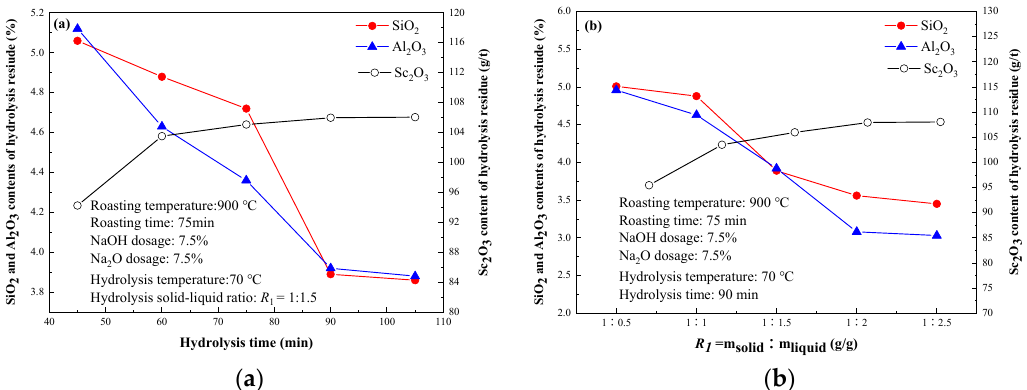
Figure 5. E ff ect results of hydrolysis leaching temperature ( a ) and hydrolysis solid to liquid ratio ( b ).